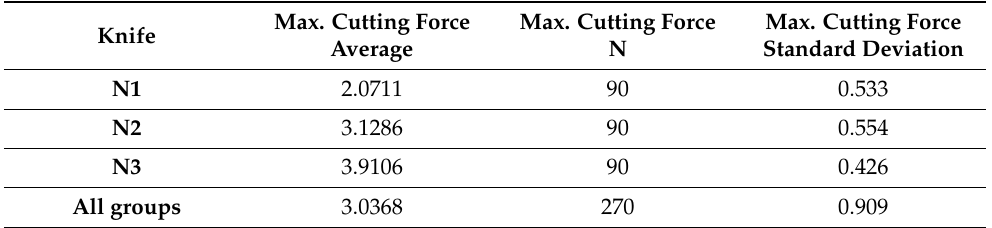
Table 3. Decomposition table of descriptive statistics of mutual interactions of diameters of sampling trees and the variable max. cutting force